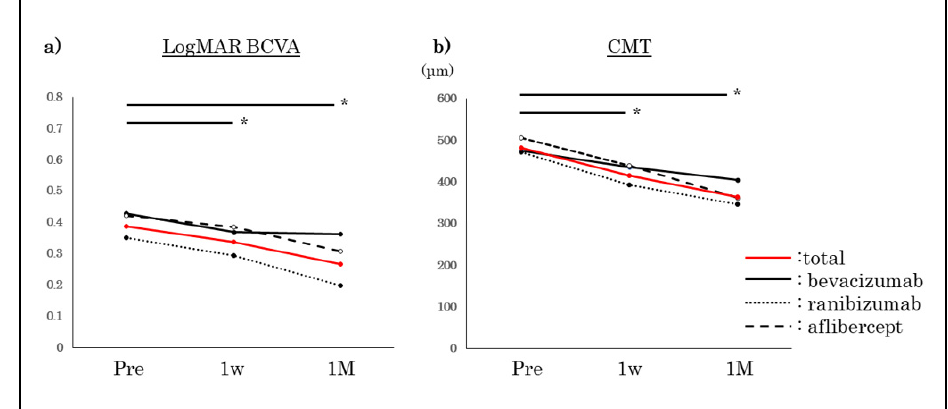
Figure 2. Changes of BCVA (a) and CMT(b) after anti-VEGF injections of three VEGF agents. The mean BCVA and CMT improved significantly after the intravitreal injection of each of the three anti- VEGF agents (total, bevacizumab, ranibizumab, and aflibercept). The data are the means ± SDs. *: p < 0.05, repeated ANOVA. *: p < 0.05, repeated ANOVA.